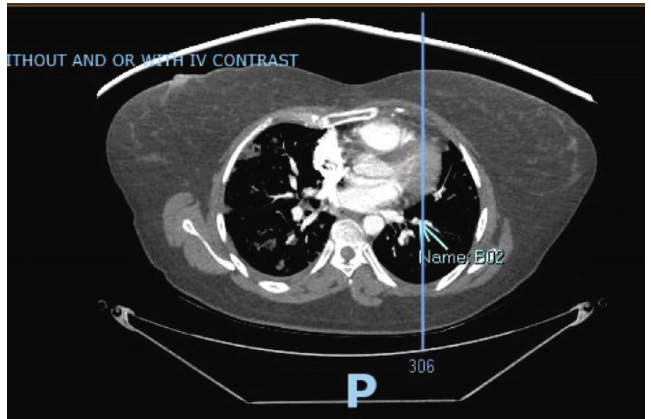
Figure 3: C.T. chest angiogram showing di ff use, multifocal nodular opacities throughout the bilateral lungs, some of which appeared cavitary, with the largest measuring approximately 1.8cm located in the lower right